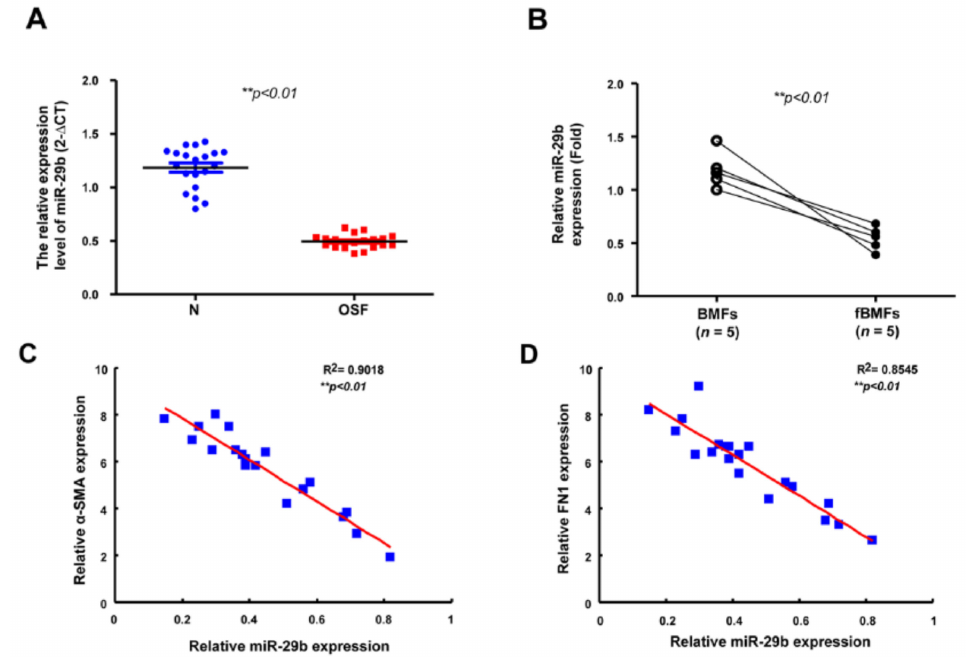
Figure 5. The expression of miR - 29b is diminished in OSF and inversely associated with fibrosis markers. ( A ) Gene expression of miR - 29b in OSF (red dots) and normal tissues ( n = 20; blue dots). ** p < 0.01 ( B ) Relative expression of miR - 29b in BMFs and fBMFs derived from OSF specimens ( n = 5). ** p < 0.01 The expression of miR - 29b was negatively correlated with ( C ) α -SMA and ( D ) FN1 expression in OSF tissues (blue dots) ** p <